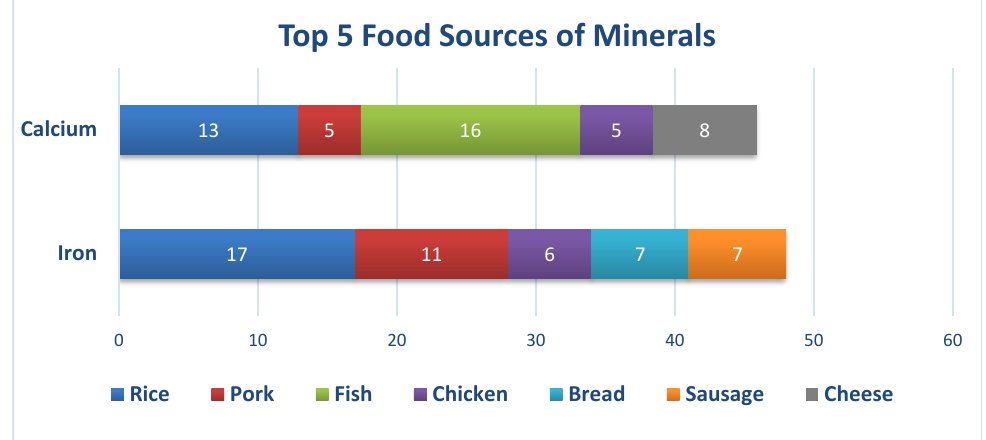
Figure 5. Percentage contributions of each food group to the calcium and iron intake of Filipino working adults.